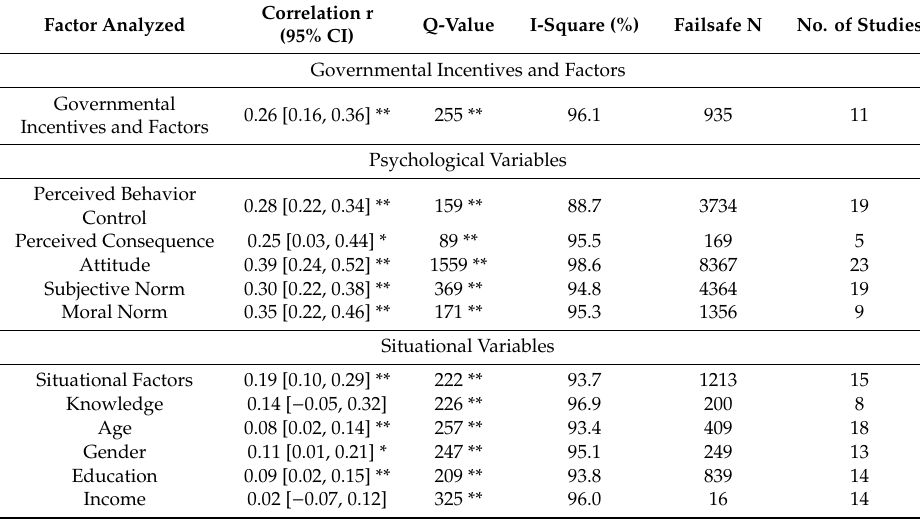
Table 1. Results of the analysis of the determined